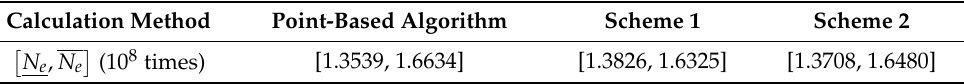
Table 5. Equivalent design cumulative axis interval results of different calculation methods.